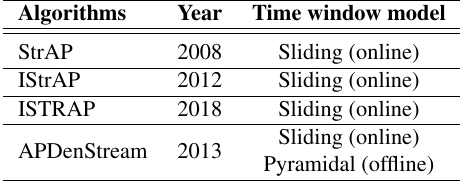
Table 1: Overview of streaming AP clustering